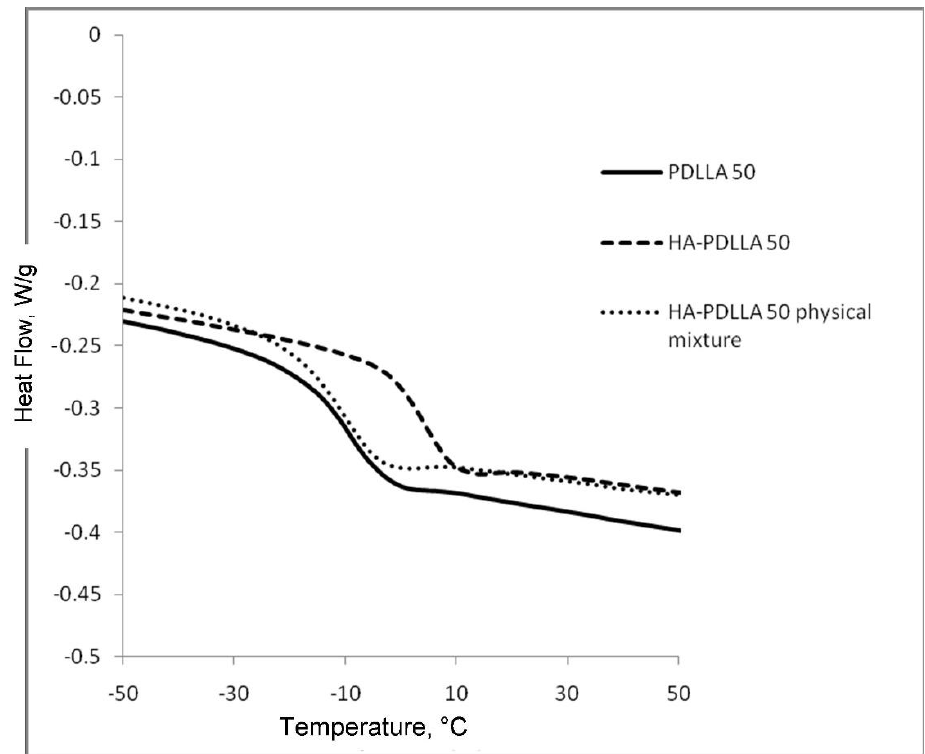
Figure 3. Differential scanning calorimetry (DSC) traces of polyesters obtained with (M)/(C) = 50: PDLLA homopolymer (PDLLA 50), HA-PDLLA graft (HA-PDLLA 50), and HA-PDLLA 50 physi- cal mixture.